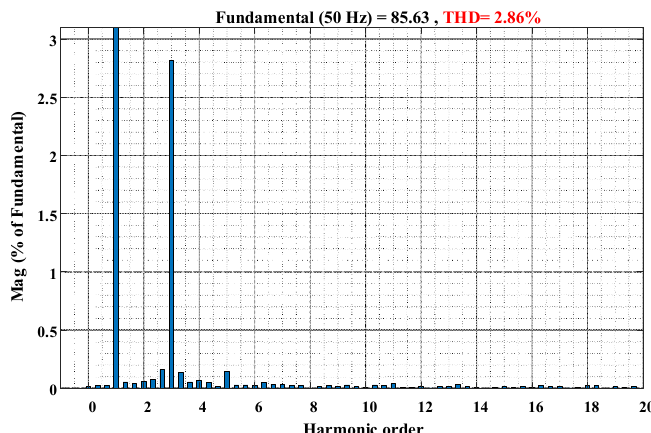
Figure 14. HVAC grid current THDi (rated power).